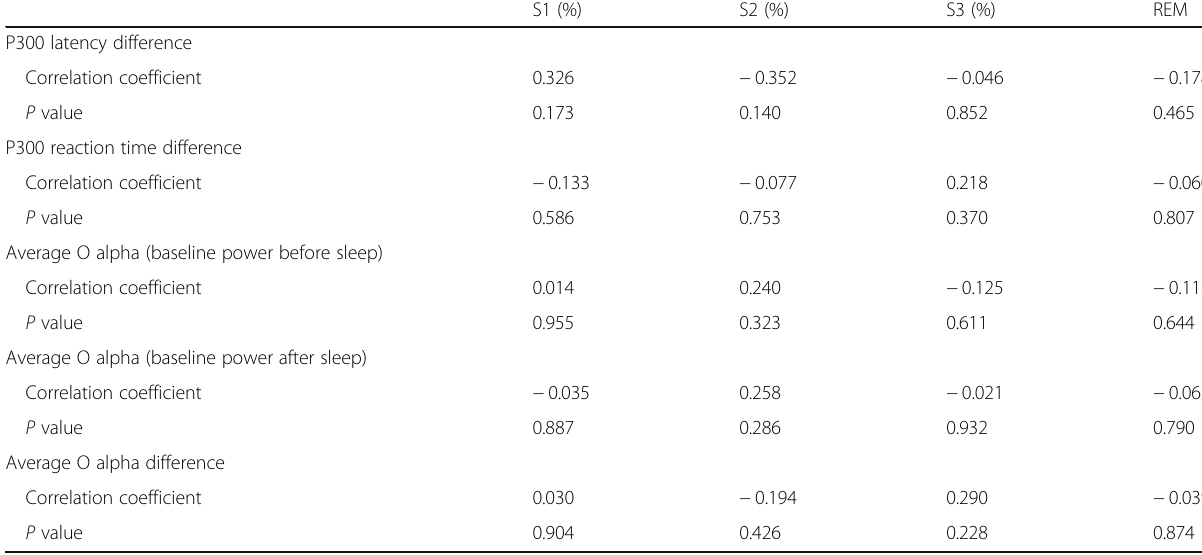
Table 3 Correlation between sleep stage percentages with P300 differences and average baseline occipital alpha power S1 (%) S2 (%) S3